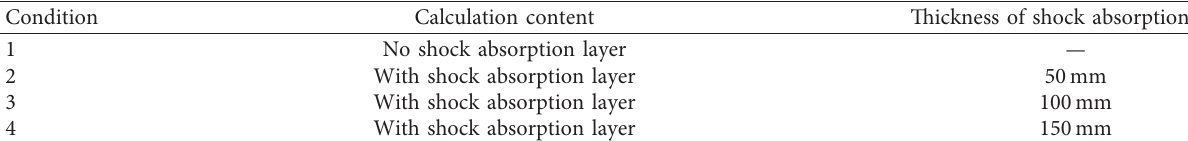
Table 2: Calculation conditions.